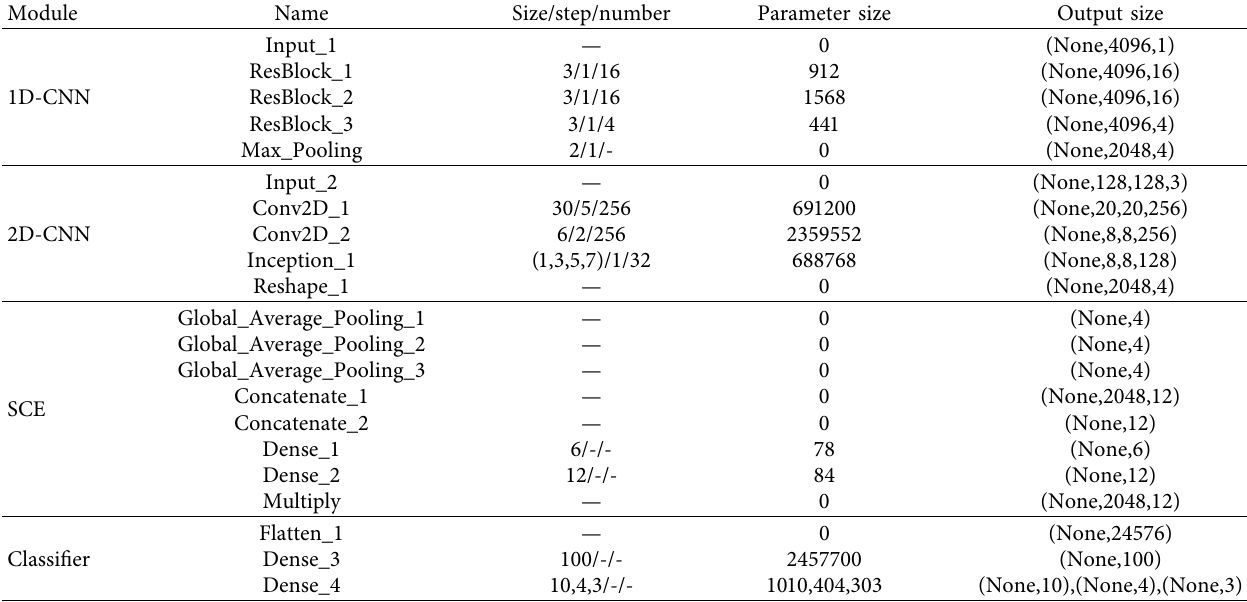
Table 1: Parameters of MFFN.